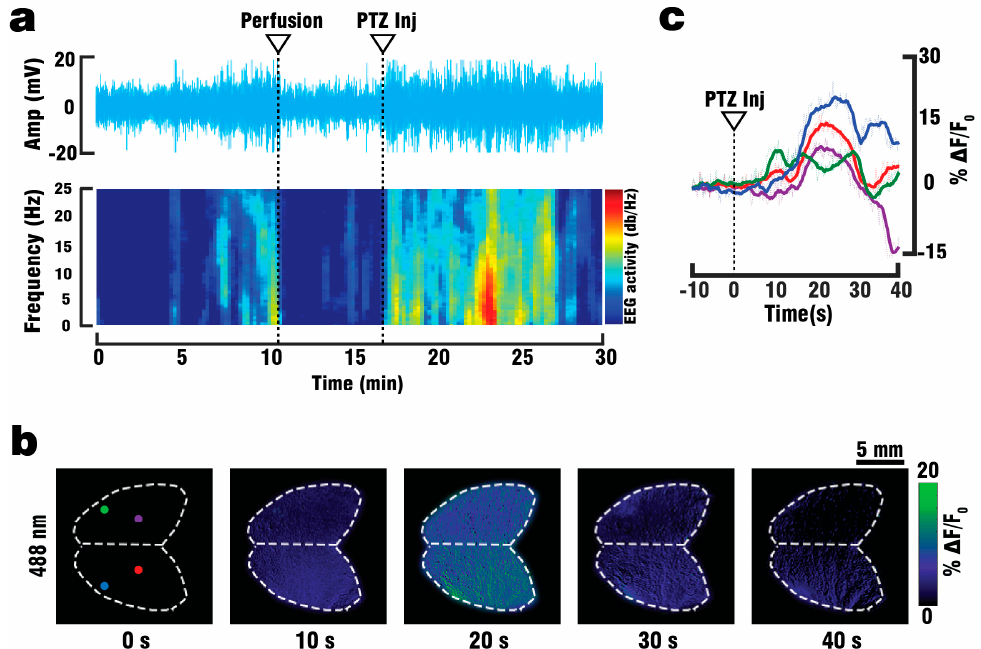
Figure 4. Validation of perfused brain viability with electroencephalography (EEG) and planar wide-field fluorescence recordings. ( a ) EEG signals recorded in a GCaMP6f mouse before and after cardiac perfusion. The signal power spectra represent the frequency distribution of the brain activity. Following the addition of Pentylenetetrazol (PTZ) to the perfusion solution, an increase in both signal amplitude and its 10–20 Hz frequency components could be detected. ( b ) Temporal sequence of fluorescence-recorded brain activation maps in response to PTZ injection at t = 0. ( c ) Background-subtracted and normalized fluorescence signal traces whose position is indicated in panel B.